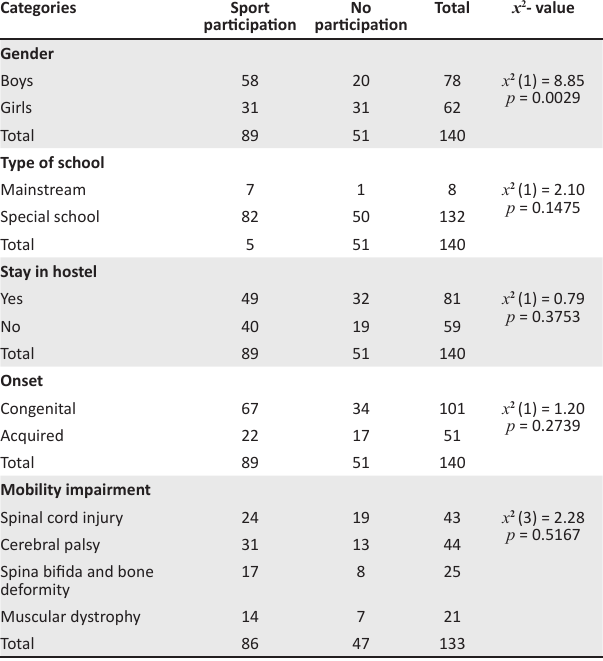
TABLE 1: Differences with regard to gender, type of school, hostel dwelling, time of acquired impairment and type of mobility impairment of learners who participate in sport and those who do not